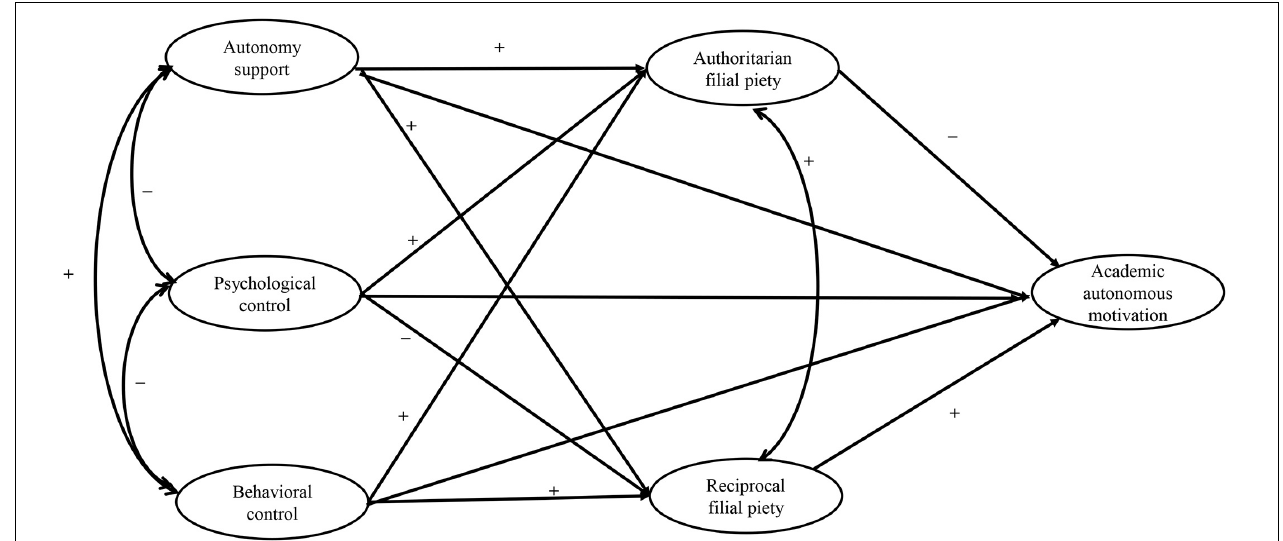
FIGURE 1 | Conceptual model (+ refers to the positive relation and – refers to the negative relation).